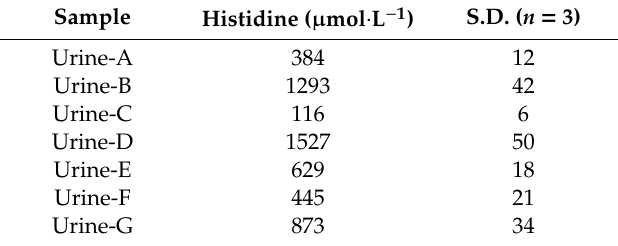
Table 5. Analysis of random urine